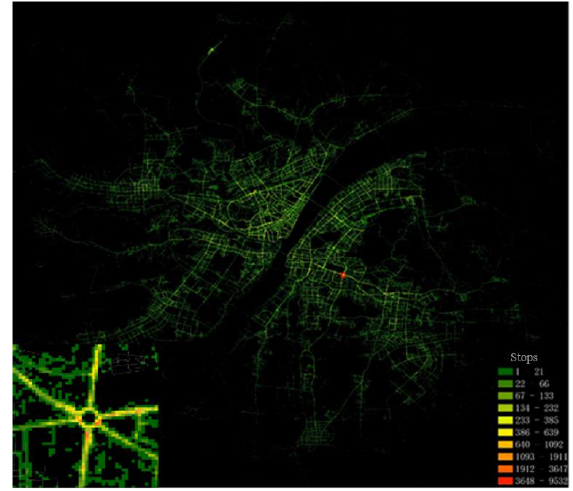
Figure 1. Gird division of the study area in Wuhan, China